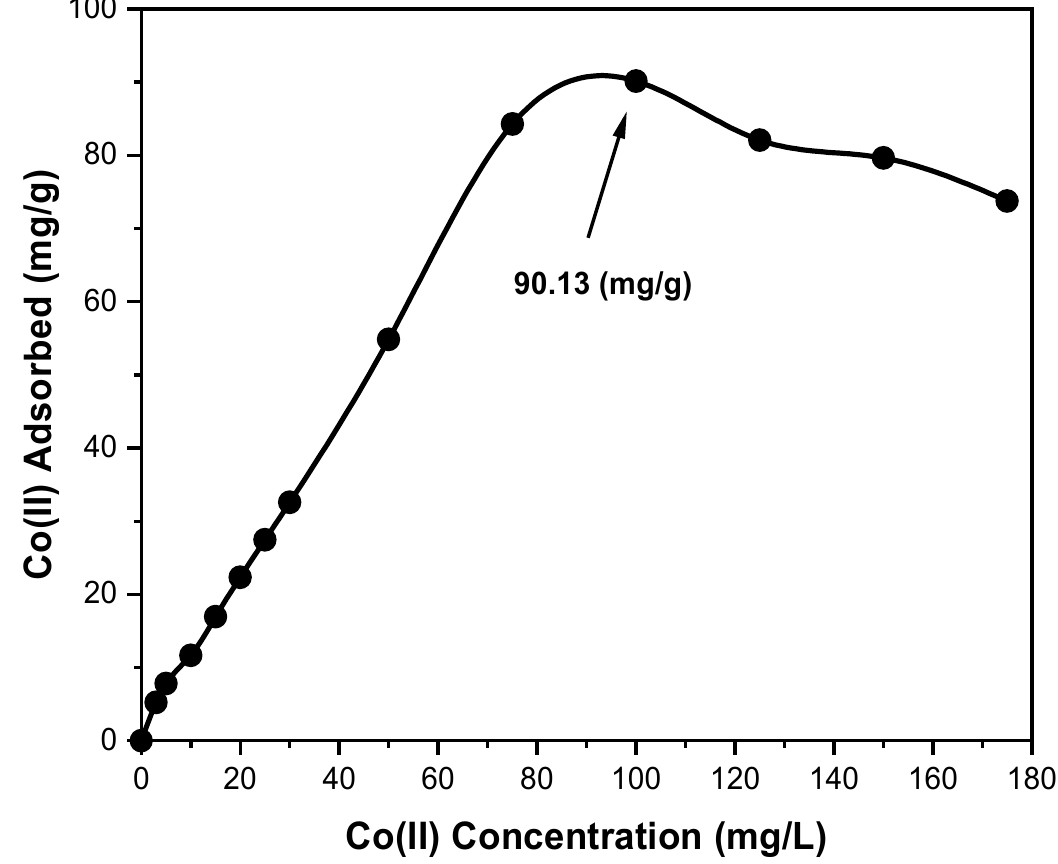
Figure 9. The Co(II) ion adsorption profile on 30 mg of A-SPES in relation to the concentration at 25 °C and pH 6.0.